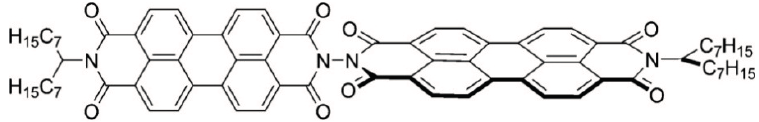
Figure 7. Twisted PDI dimer. Adapted from [100] with permission from the American Chemical